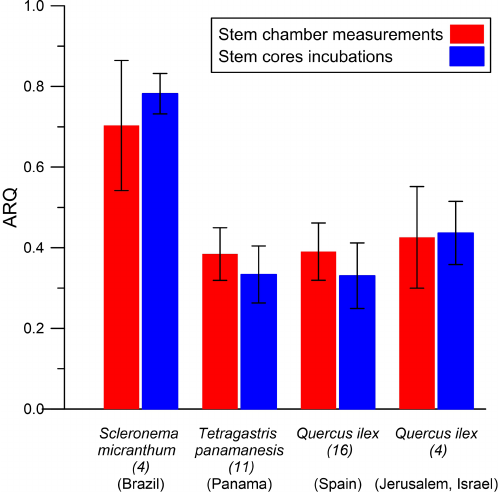
Figure 8. Comparisons of stem chamber steady-state ARQ (ratio CO 2 efflux / O 2 influx for tree stems) to ARQ measured from incu- bations of stem cores (ratio CO 2 increase / O 2 decrease), by species ( n individuals) in different sites. Values are means ±